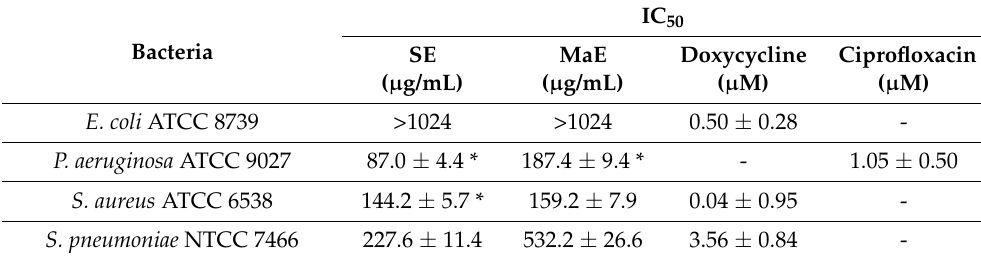
Table 1. Antibacterial effects of P. americana seed extracts.